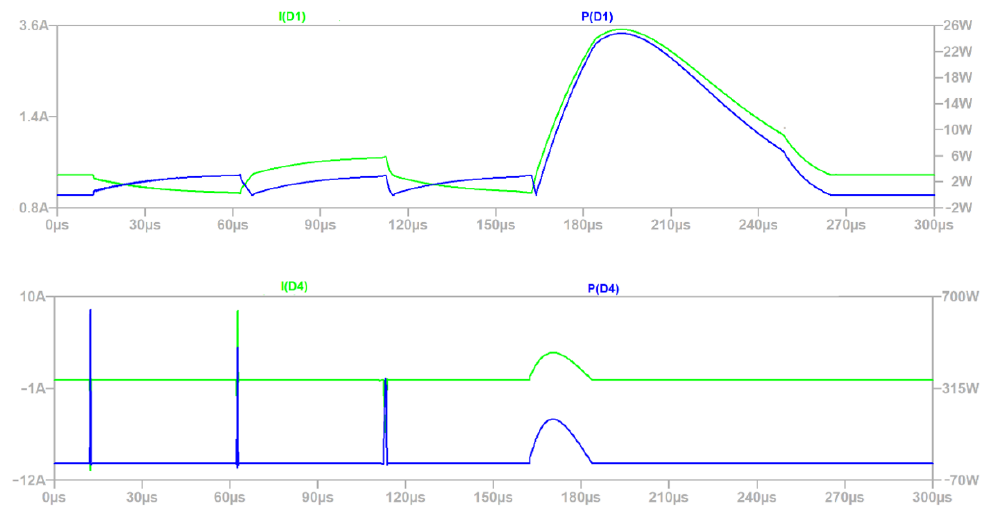
Figure 10. Power and current waveforms of D1 and D4.